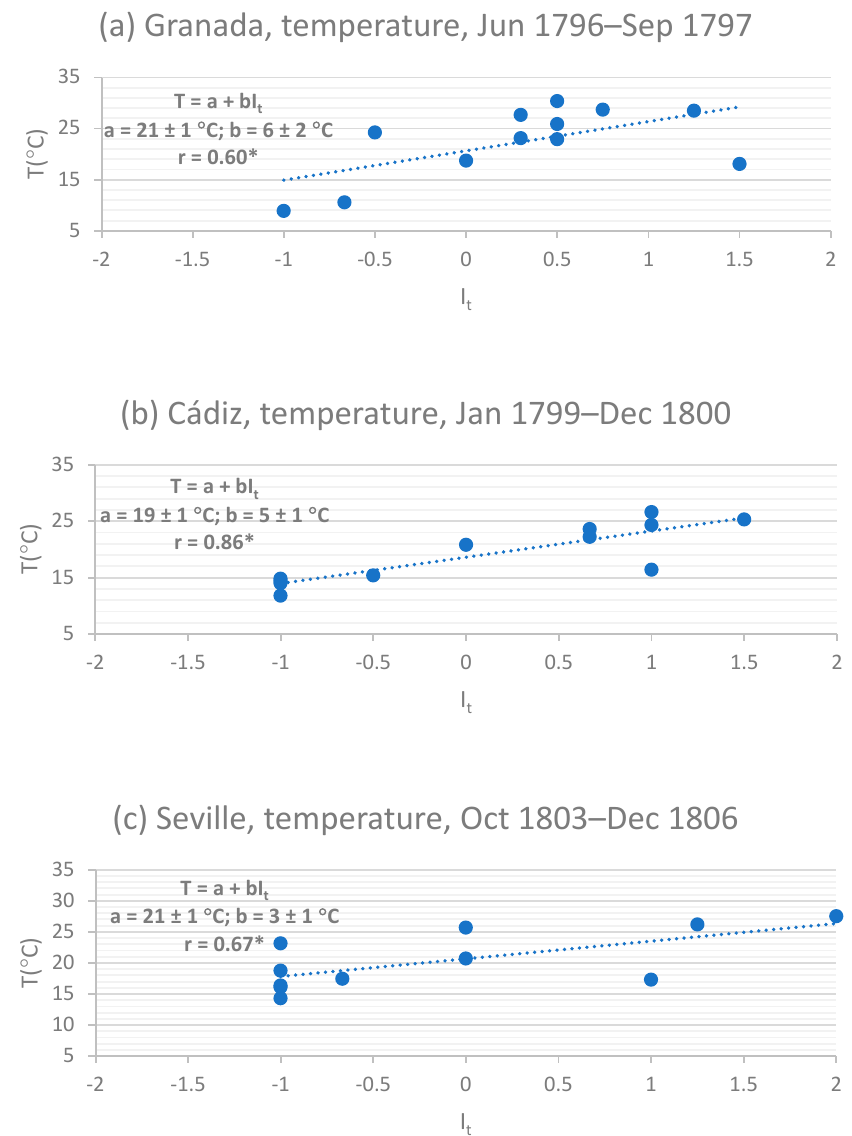
Figure 10. Comparison between monthly indices I t from CMEI and monthly mean temperatures at midday from EMD (EMOSSv2) in ( a ) Granada, June 1796 to September 1797, ( b ) Cádiz, January 1799 to December 1800, and ( c ) Seville, October 1803 to December 1806. Linear regression equations and correlation coefficients are included (* = significant at the 95% confidence level).